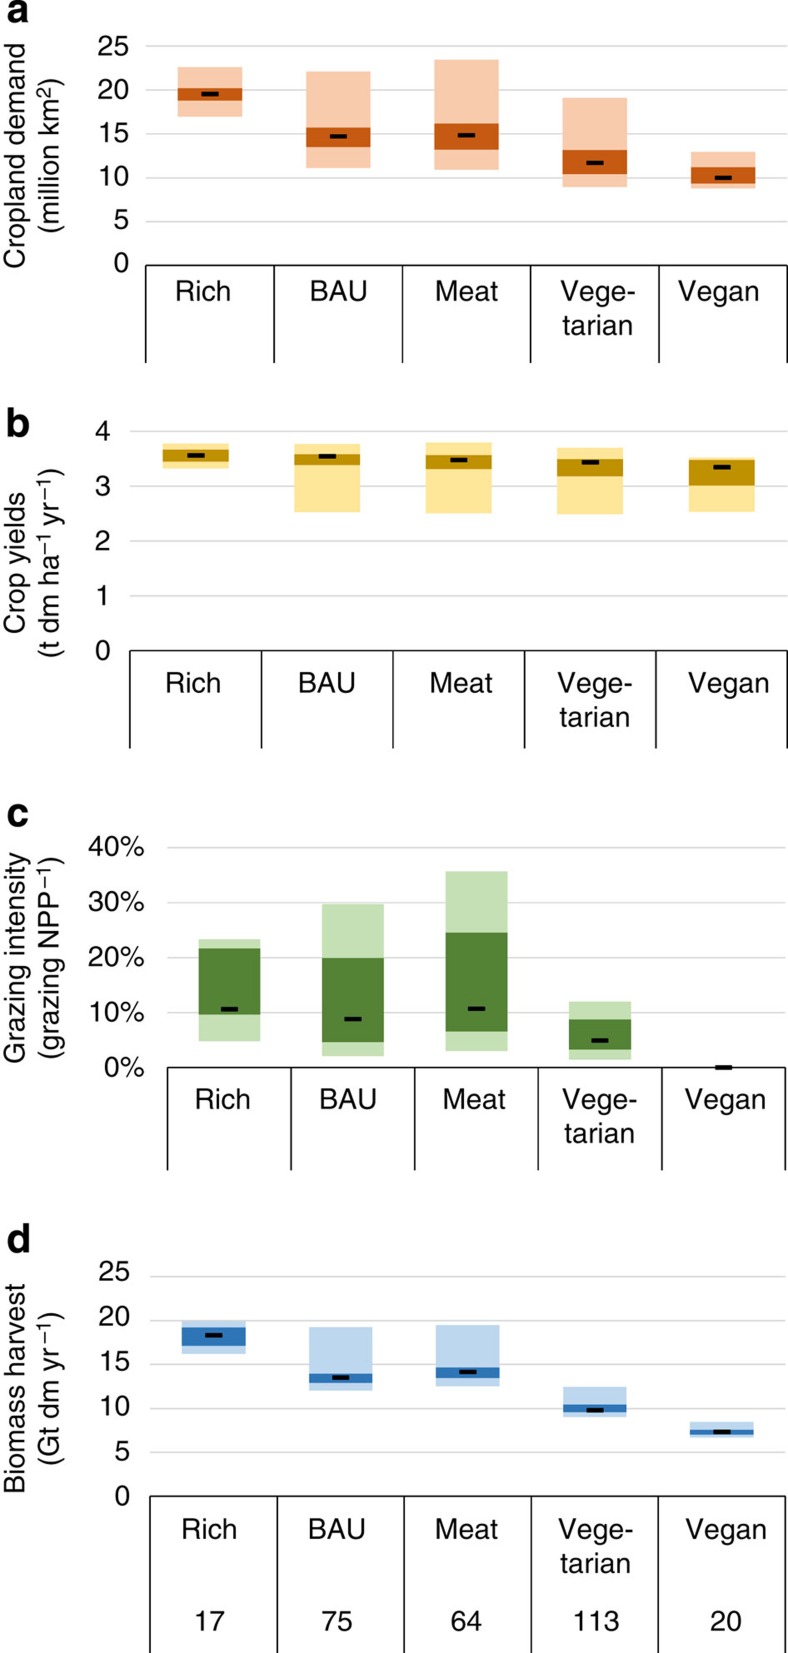
Characterization of feasible and probably feasible scenarios, broken down into human diets.(a) Cropland demand, (b) average cropland yields, (c) grazing intensity, measured as grazing harvest in per cent of actual NPP and (d) biomass harvest, that is, total biomass harvested globally for food supply, given as dry matter. Dark boxes indicate the two inner quartiles (>25 and <75%) of all feasible scenarios; light grey-shaded boxes indicate the minimum and maximum values. Small lines indicate the median. Numbers below diets indicate the number of feasible scenarios. The total number of scenarios per diet is 120, with the exception of the VEGAN diet, with 40 scenarios. For abbreviations, see the text and the caption of Fig. 1. Colour codes are aimed to facilitate comparison with Supplementary Figs 3–6.